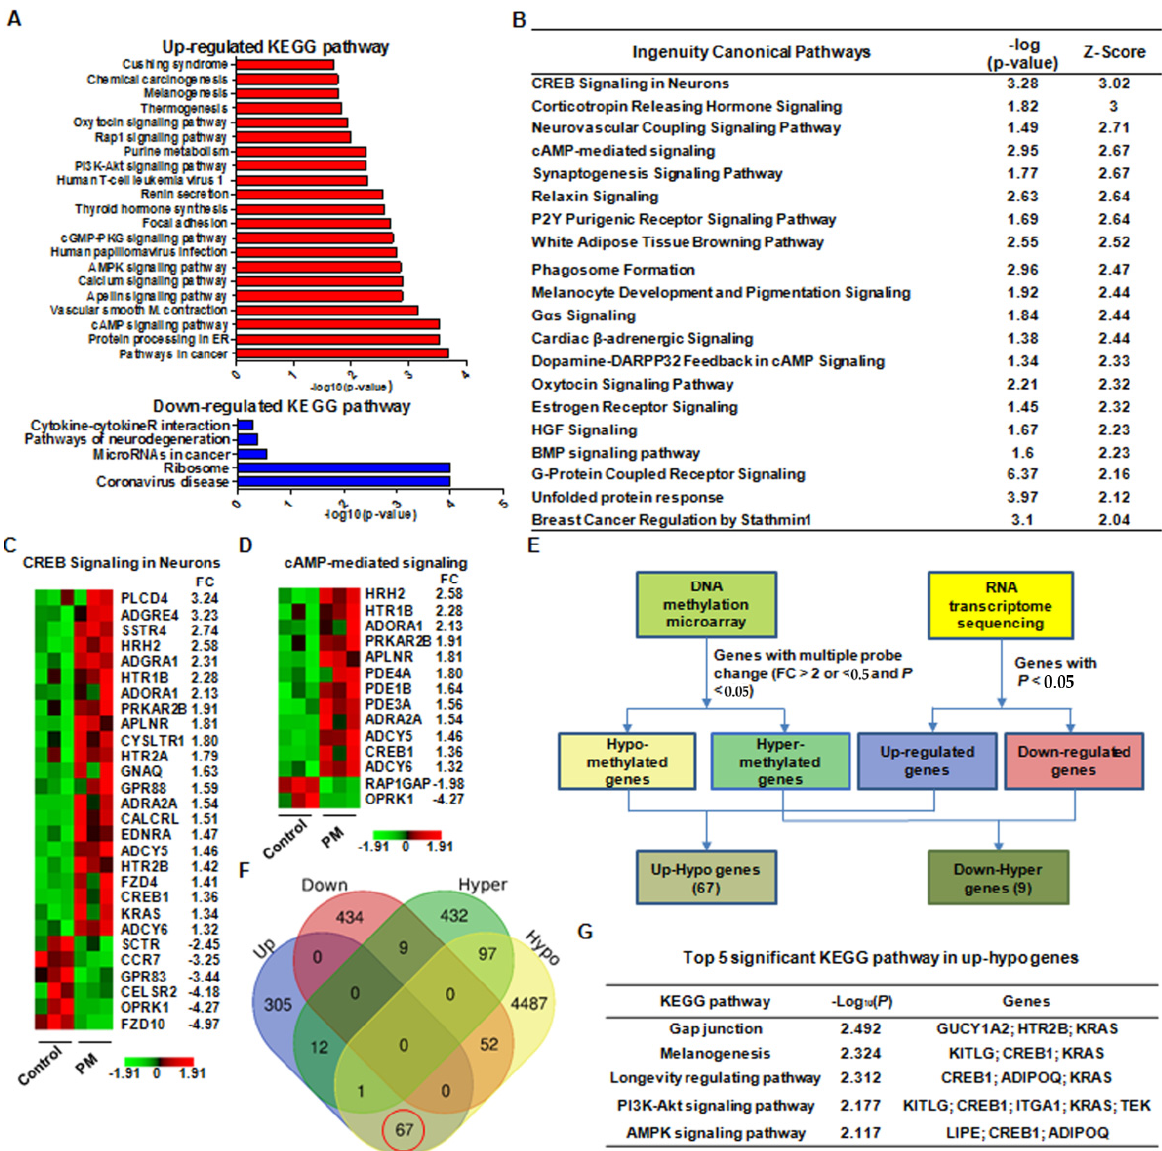
Figure 5. ( A ) Kyoto Encyclopedia of Genes and Genome (KEGG) pathways associated with the significantly upregulated and downregulated differentially expressed genes (DEGs) between particulate matter (PM)-exposed and control (non-PM) rats ( p < 0.05). ( B ) Canonical pathways with significant Z-scores (>2) identified using ingenuity pathway analysis. Heatmaps showing the DEGs in the ( C ) cAMP response element-binding protein (CREB) and ( D ) cAMP signaling pathways. ( E ) Schematic diagram showing the methods and criteria for gene analysis. ( F ) Venn diagram showing the combined DNA methylation and transcriptome data. The red circle indicates 67 genes exhibiting hypomethylated/upregulated expression. ( G ) The top five KEGG pathways associated with the hypomethylated/upregulated genes.